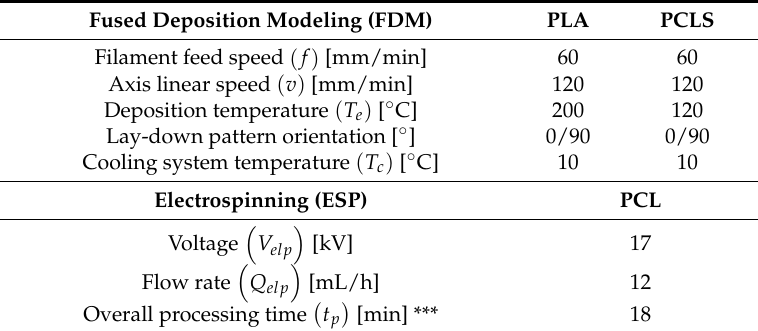
Table 3. Process parameters for the manufacturing of bimodal scaffolds.